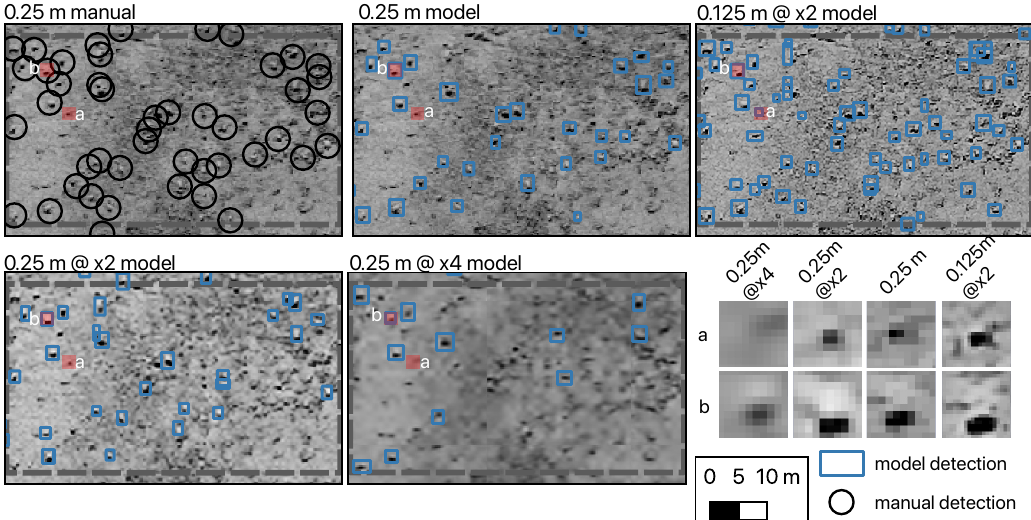
Figure 9. Subsets of the native and upscaled mosaics for the small boulder facies. Manual and model detections are marked. Insets detail the appearance of individual boulders in the different mosaics. The location of the shown mosaic subset in the validation mosaic is marked in Figure